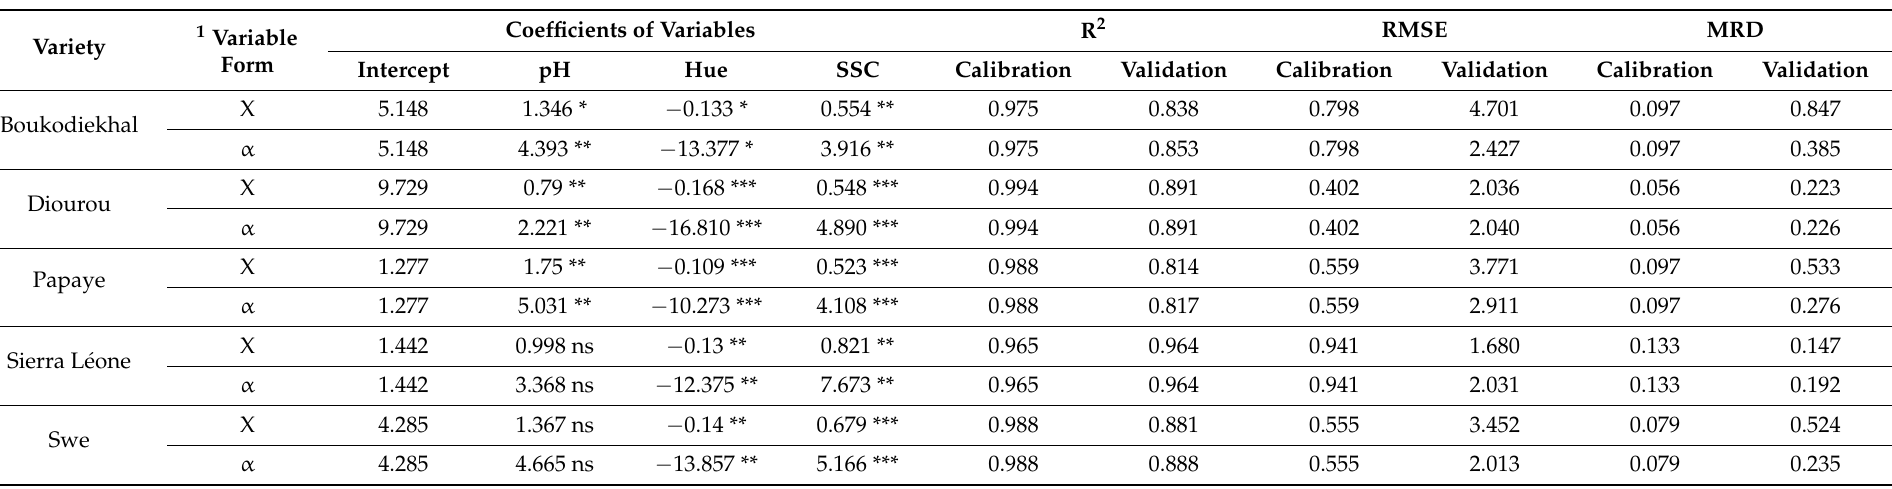
Table 3. Model coefficients and parameters for intra-varietal prediction of mango ripening by multi-linear regression.